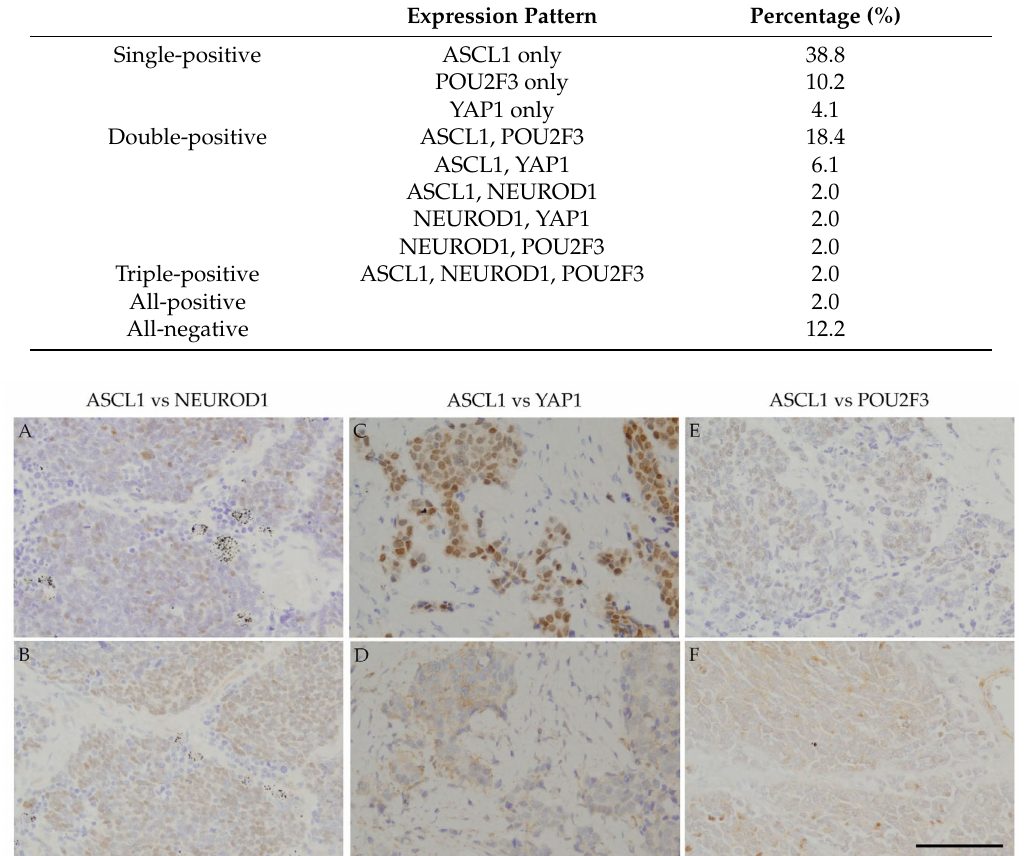
Table 4. Combined expression of ASCL1, NEUROD1, YAP1, and POU2F3